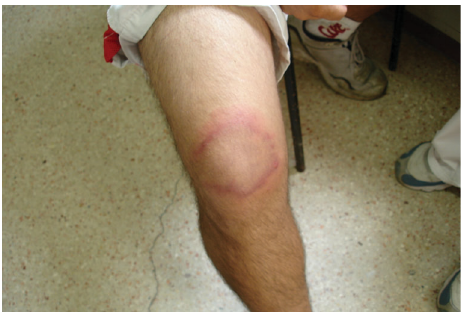
Figure 6. Blister lesion in ankle following tick bite episode. His- topathological analysis compat- ible with benign lymphocytoma.